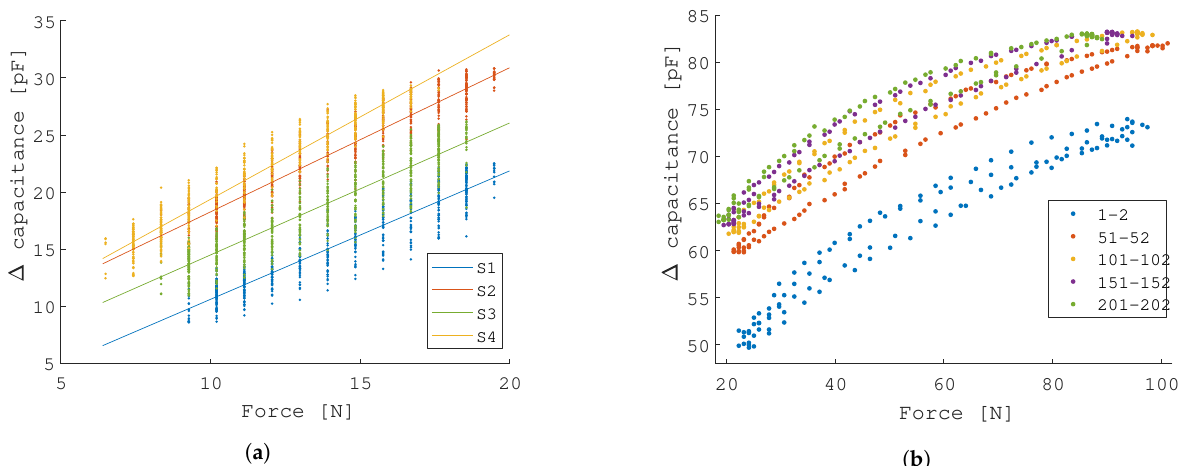
Figure 8. Test-bench characterization results (B): the four printed sensors exhibit negligible differences in response. On cyclic experiment, the drift of the sensor can be observed. After 100 cycles, the drift settles. ( a ) Four pressure sensor were printed and assessed. A cyclic load at a frequency of 0.1 Hz is applied. ( b ) A cyclic experiment at 0.1 Hz to explore the wide sensing range of the sensor, the hysteresis that is exhibited, and the drift in a dynamic